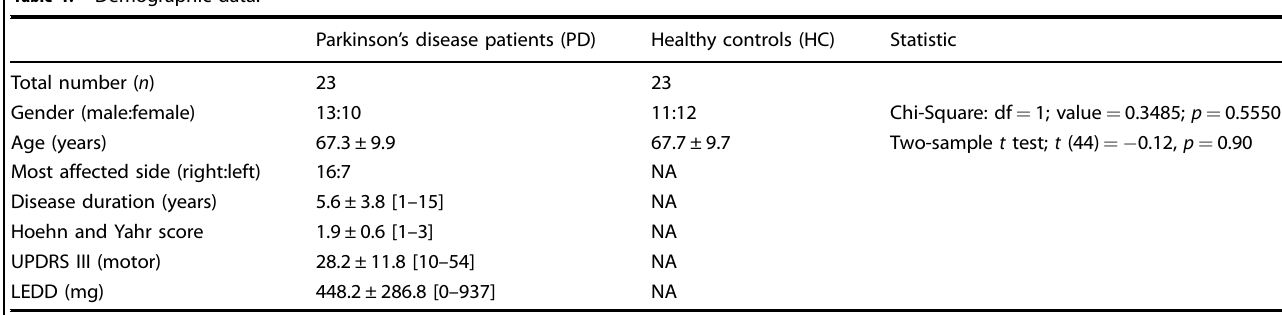
Table 1. Demographic data. Parkinson ’ s disease patients (PD) Healthy controls (HC)